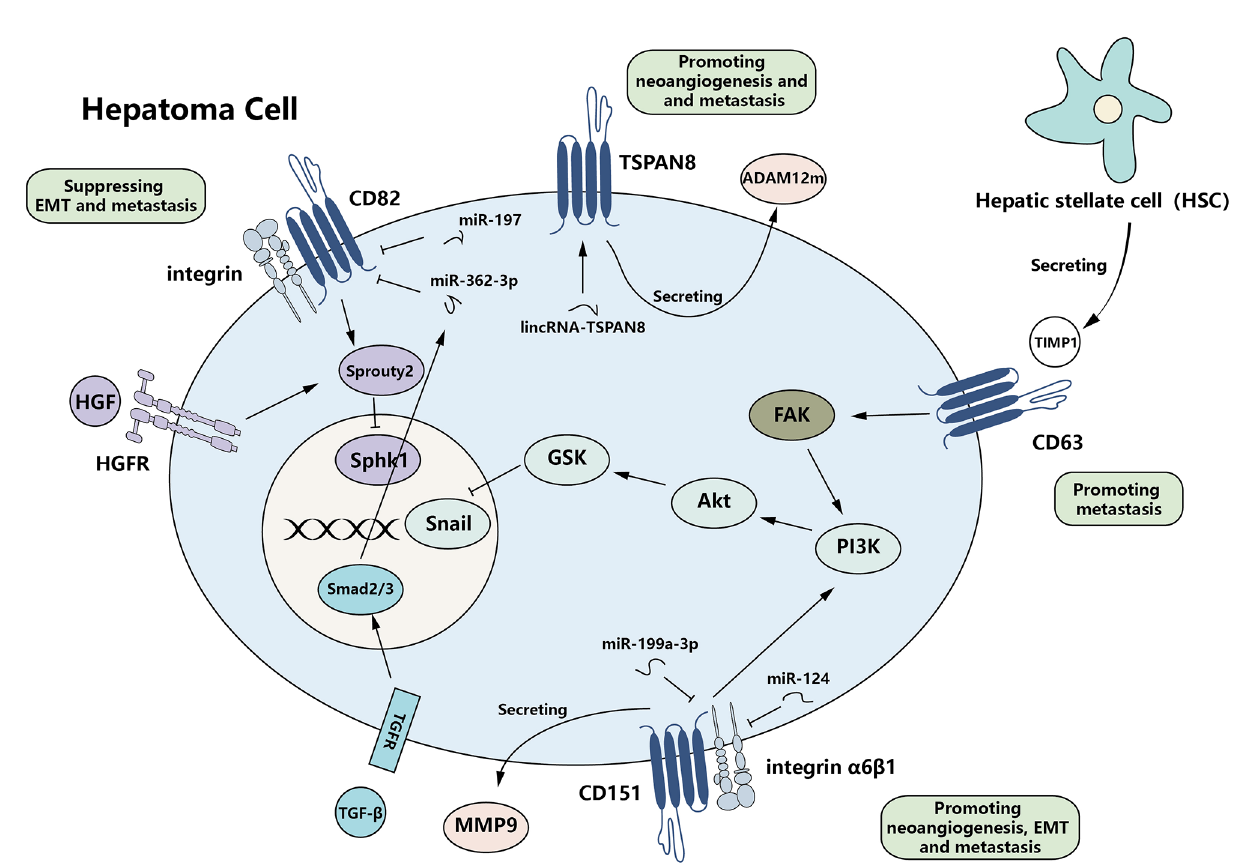
FIGURE 2 | Complexity of the function of tetraspanins in HCC metastasis. Tetraspanins can bidirectionally regulate HCC metastasis by affecting EMT-related protein expression and invasiveness/migration. CD63, CD151, and TSPAN8 serve as promoters of metastasis, while CD82 functions as a repressor. Multiple signaling pathways are active and fi nally regulate the expression of downstream effectors. Meanwhile, various non-coding RNAs can regulate the expression of tetraspanins. HCC, hepatocellular carcinoma; EMT, epithelial – mesenchymal